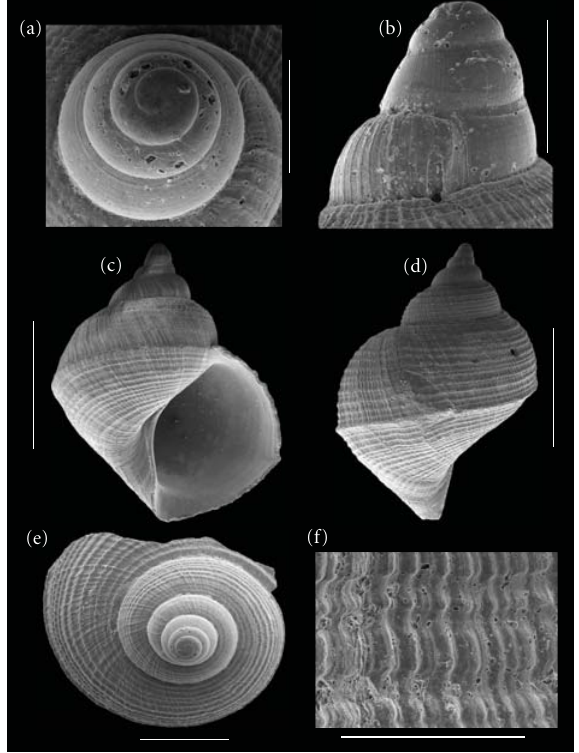
Figure 6: (a–f) Alora sp. (MNRJ 17.166); (a) and (b) protoconch view, (c) ventral view, (d) dorsal view, (e) apical view, and (f) detail of teleoconch ornamentation. Scale bars: (a) 200, (b) 300, (c) 1mm, (d) 2mm, (e) 500 μ m, and (f) 400 μ m.